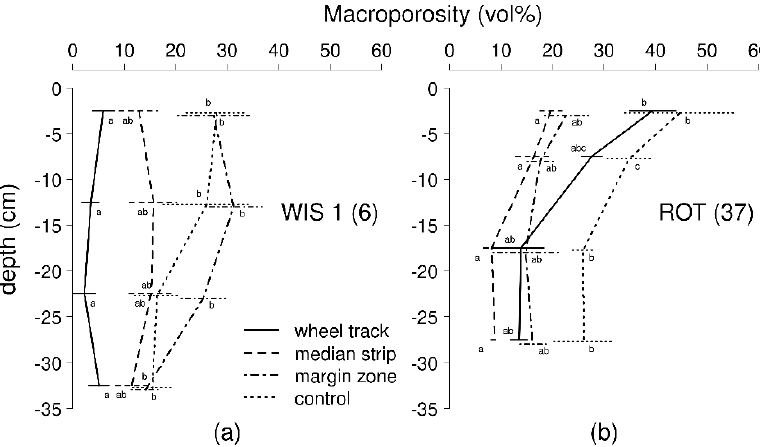
Figure 4. Macroporosities for the skid trail strata and control situation at ( a ) WIS 1 (6) and ( b ) ROT (37). Statistical distinctness between the strata was tested with the multiple non-parametric Kruskal–Dunn test at a significance level of p < 0.05 and is marked by small Arabic letters. The horizontal lines represent the two-fold standard deviations.